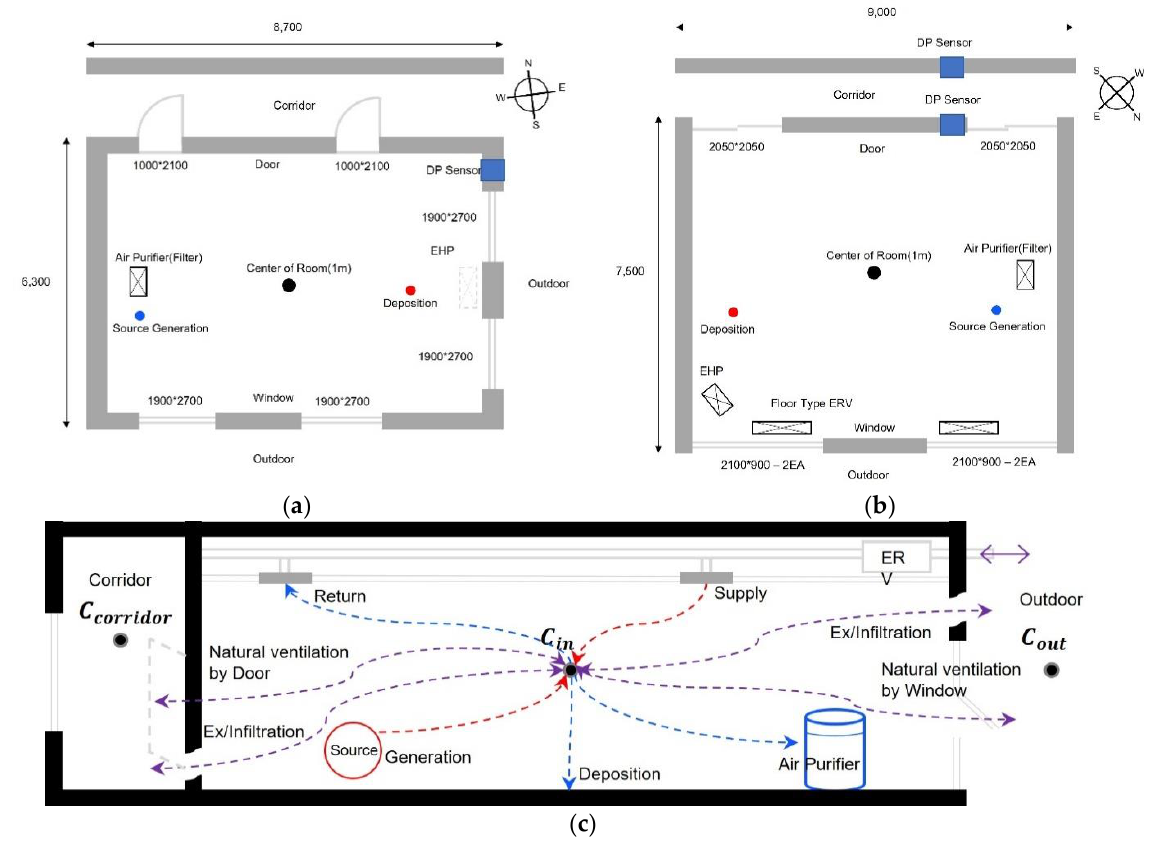
Figure 4. Floor and section plans of Case D and Case I (unit: mm). ( a ) Floor plan of Case D. ( b ) Floor plan of Case I. ( c ) Section plan of Case D and Case I.